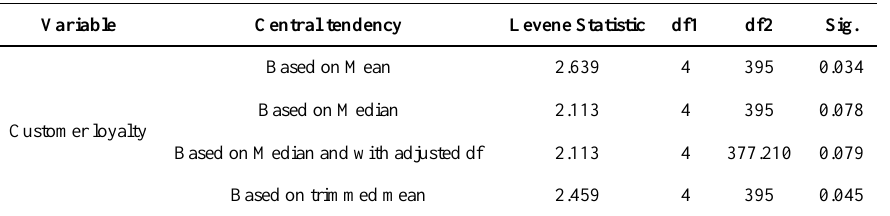
Table 15. Test of Homogeneity of Variances